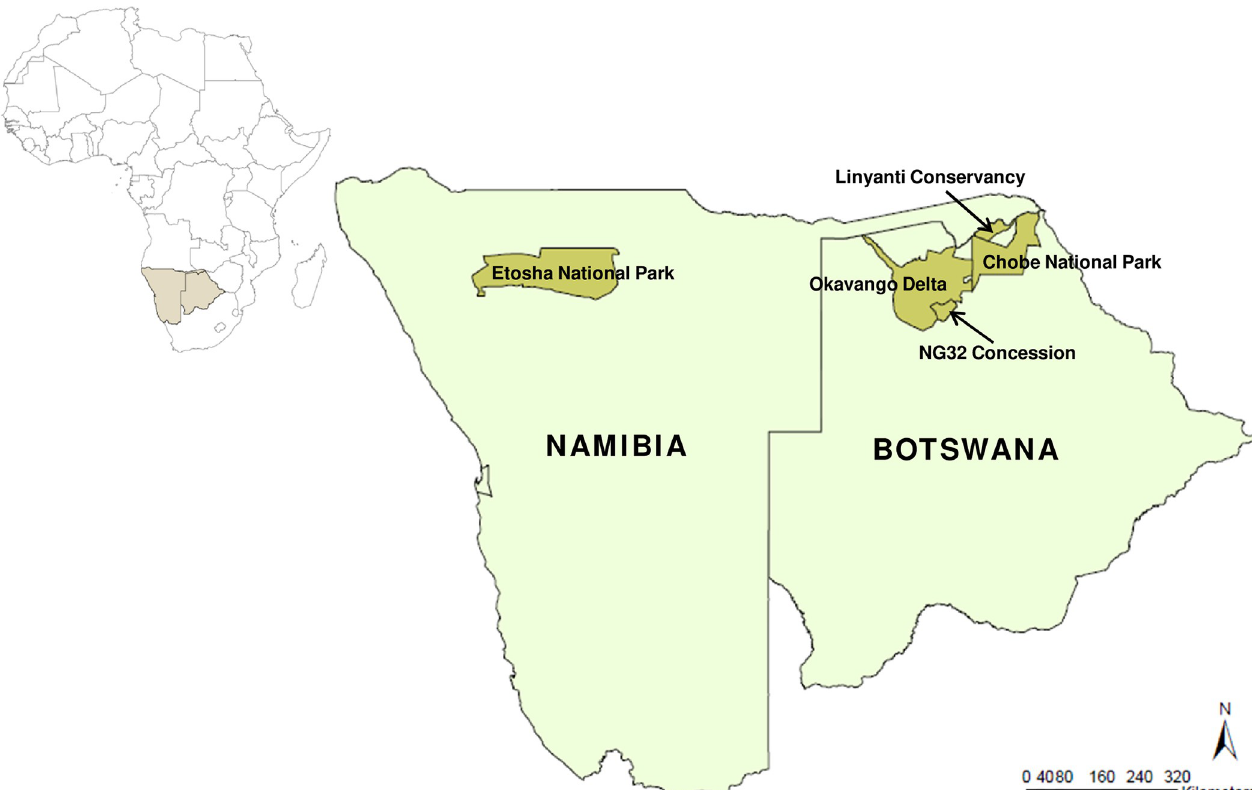
Fig 1. Location of the study areas. The map of the African continent shows the countries of Namibia and Botswana shaded, and the protected areas within these countries where the study was conducted. Maps were generated with ArcGIS (ESRI ArcMap v.10.0).